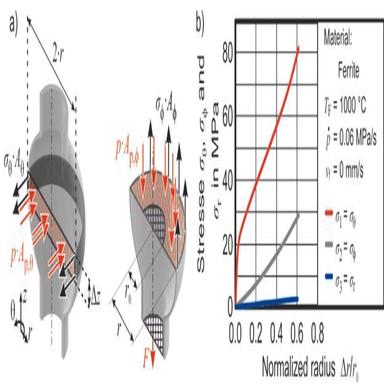
a) Forces acting in the pole of the specimen during the hot-tube-bulge test in tangential- and meridian direction and b) resulting stress components over the normalized radius Δr/r following Eqs. (4), (5) and (6).